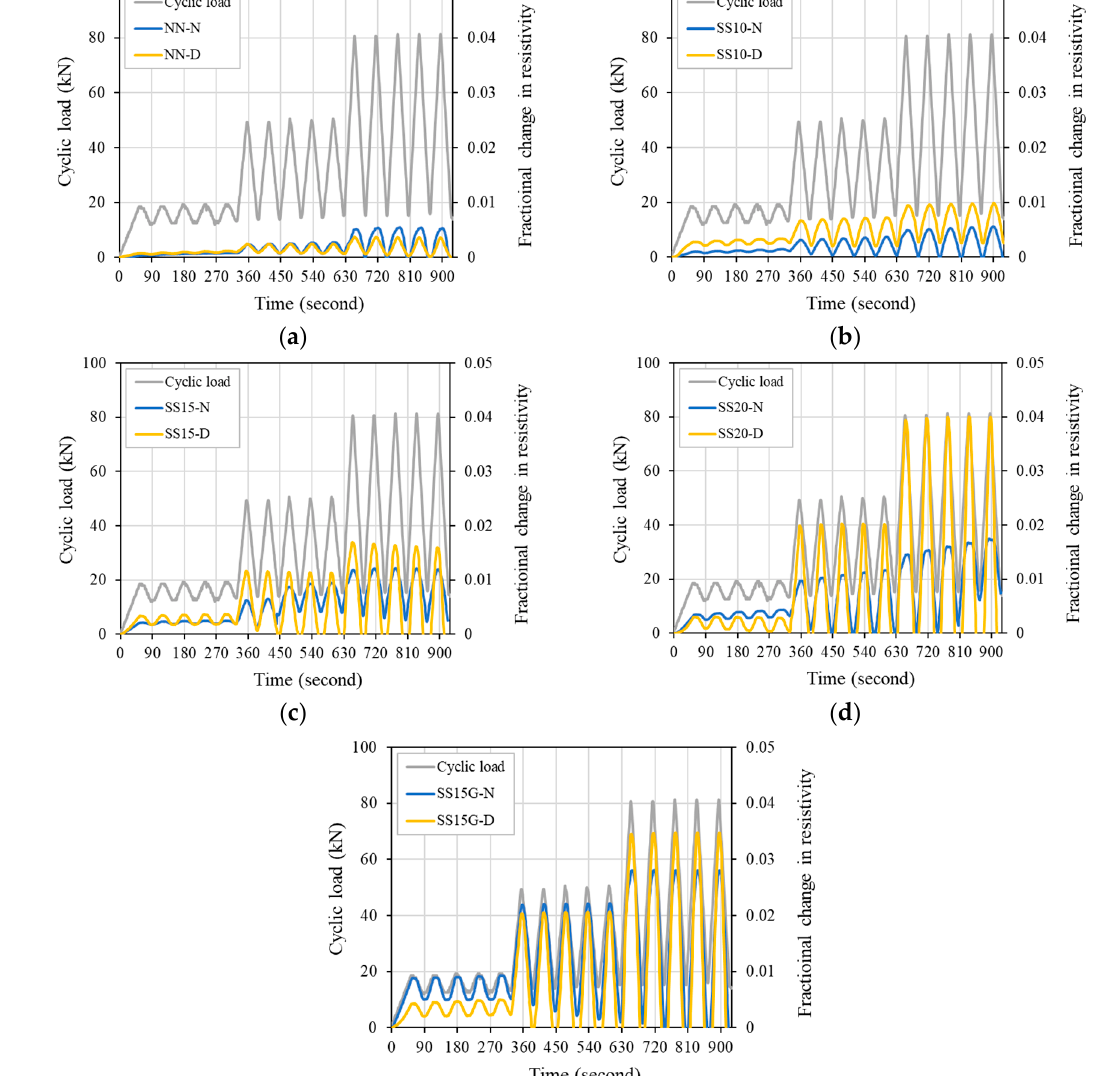
Figure12. Moisturee ff ectonFCRresponseofconcrete: ( a )NN;( b )SS10; ( c )SS15; ( d )SS20; and( e )SS15G. Figure 12. Moisture effect on FCR response of concrete: ( a ) NN; ( b ) SS10; ( c ) SS15; ( d ) SS20; and ( e ) SS15G.